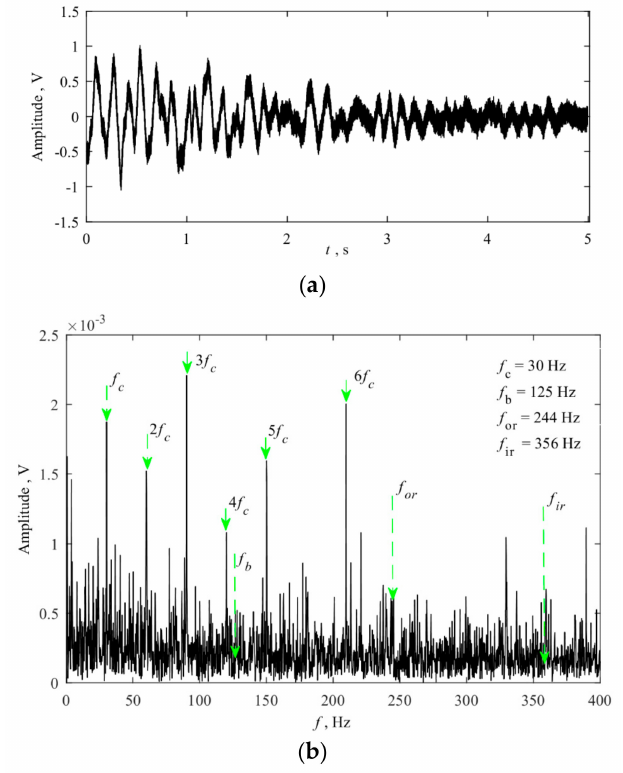
Figure 9. The signal of the MWA with a cage fault: ( a ) time domain waveform; ( b ) envelope